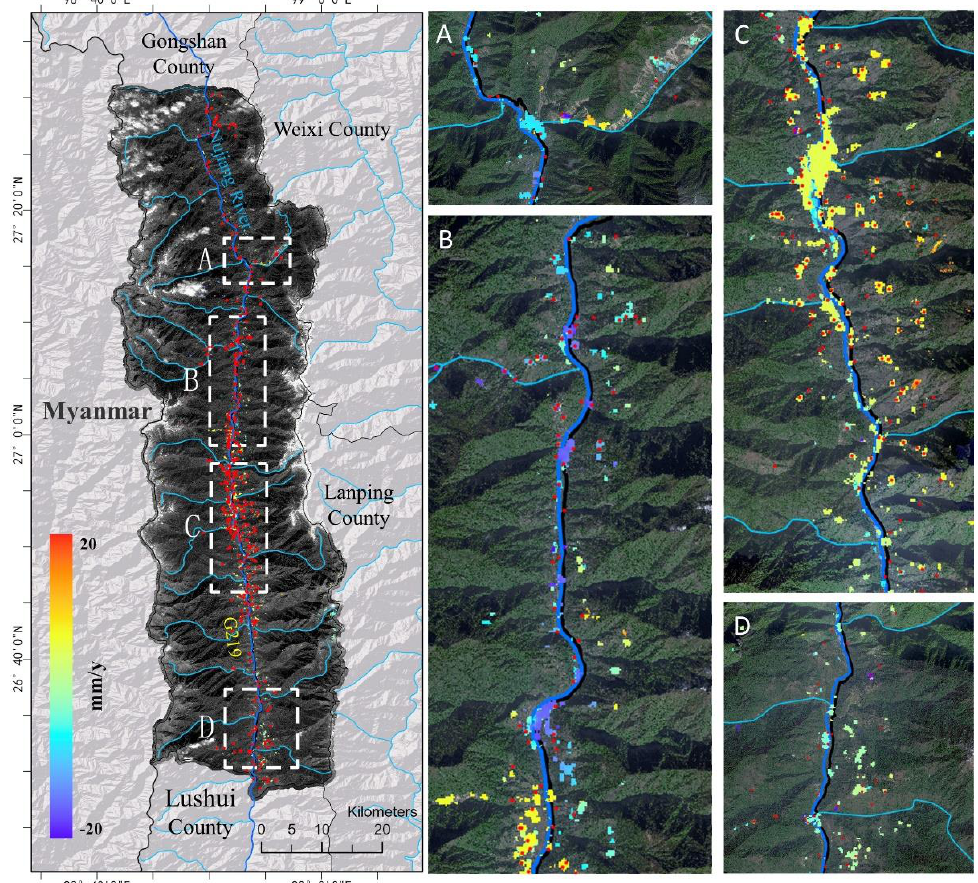
Figure 5. The surface deformation detected by SBAS − InSAR. Here, the color bar in the left panel shows the color of different annual deformation rates in the LOS direction, where a negative value indicates increasing distance from the satellite, and a positive value indicates decreasing distance from the satellite. The red points are references collected by visual interpretation. Panel ( A – D ) are used to display specific regions of the left panel more